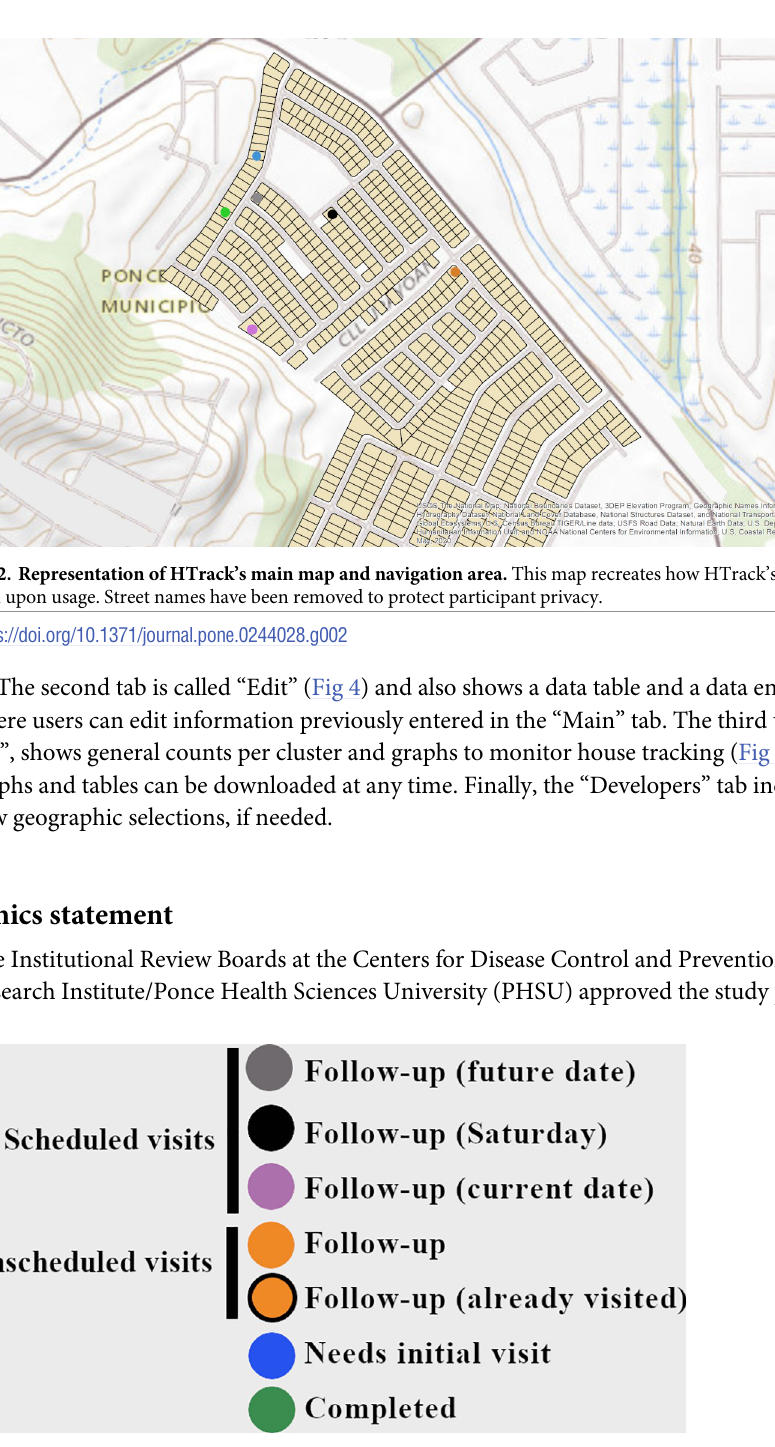
Fig 3. HTrack color-scheme. Blue markers were used for structures that needed an initial visit. Orange markers were used for structures that required unscheduled follow-up visits (a black outline indicated that the structure had already been visited for the day, but still required a follow-up visit). Among scheduled visits, black markers were used for visits scheduled on a Saturday. Grey markers were used for visits scheduled on a weekday. Pink was used for homes that had a visit scheduled for that specific day. Green was used for homes that required no more visits, regardless of recruitment status.